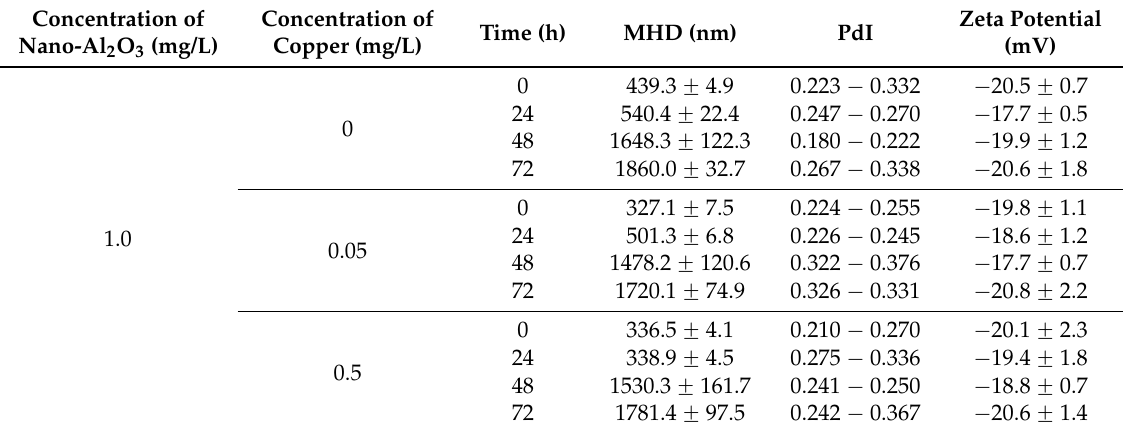
Table 3. Properties of nano-Al 2 O 3 in the exposure solution over 72